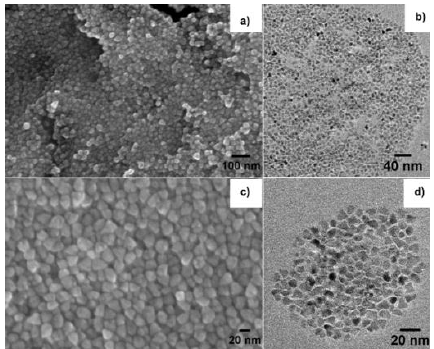
Figure 2. SEM images of N22- hot injection process (HI) ( a , c ) and high-resolution transmission electron microscopy (HRTEM) of N05-HI ( b , d ).